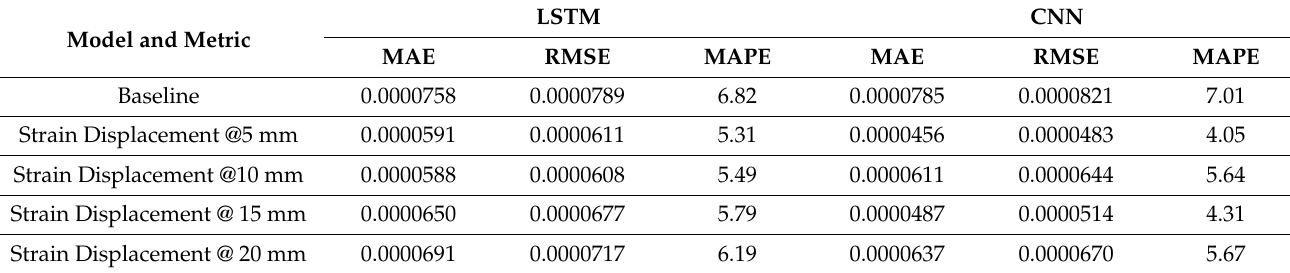
Table 6. Accuracy of deep learning models for Sample 1.